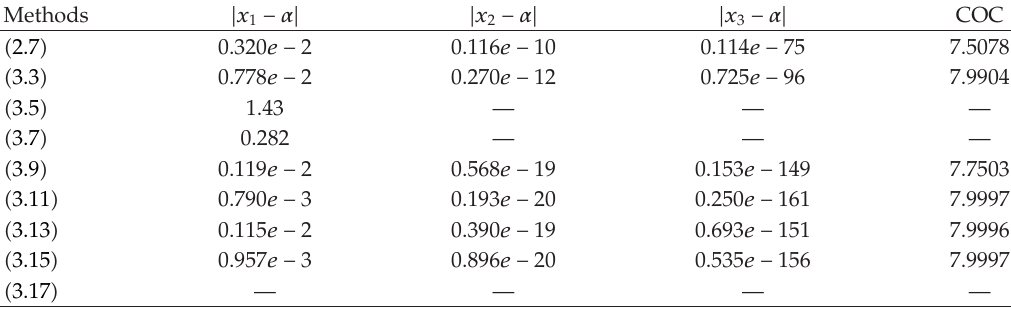
Table 6: Errors occurring in the estimates of the root of (cid:3) 4.6 (cid:4) by the methods